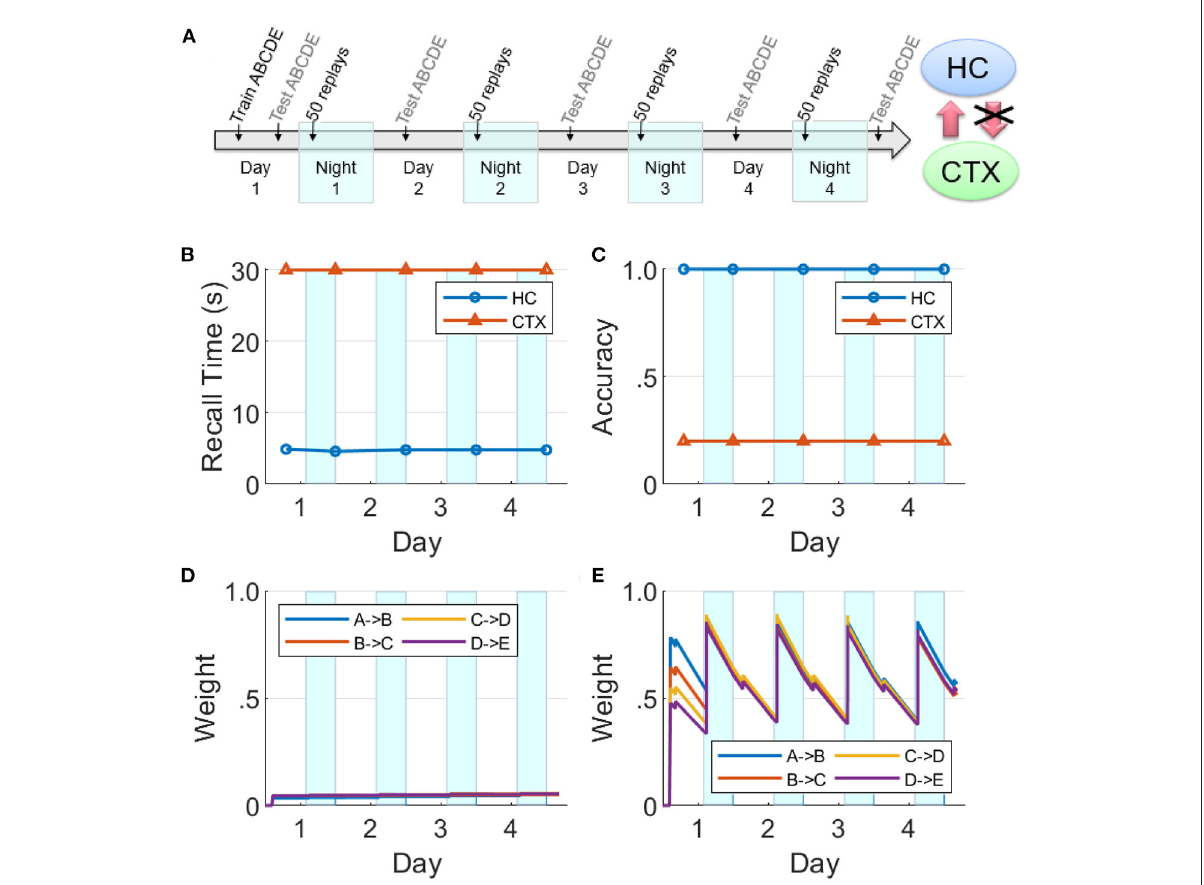
FIGURE9 Lesions of hippocampal feedback projections before training. (A) With feedback from hippocampus to cortex turned off before training, the cortical representation cannot develop. Hippocampal connections are re-learned from replay activity during the SWS periods, but little growth is seen in the cortical connections (HC, hippocampus; CTX, cortex). (B) Recall time, where 30 s is default for incomplete recalls. (C) Recall accuracy. (D) Weight strengths in CTX. (E) Weight strengths in